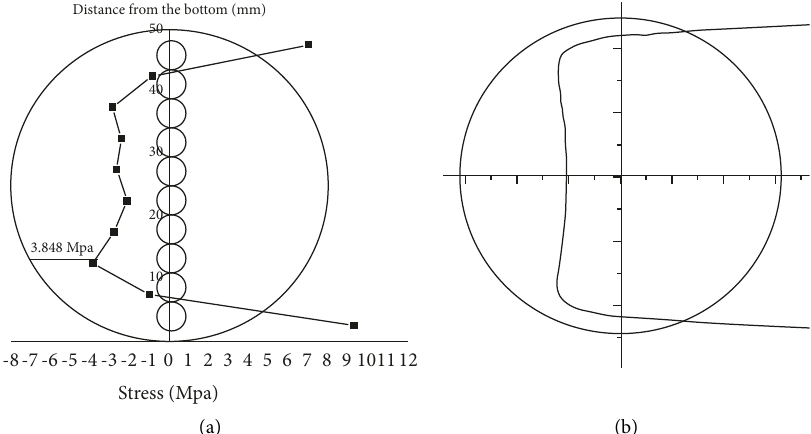
Figure 9: Horizontal stress distribution at the central axis of the specimen: (a) numerical simulation and (b) theoretical curve